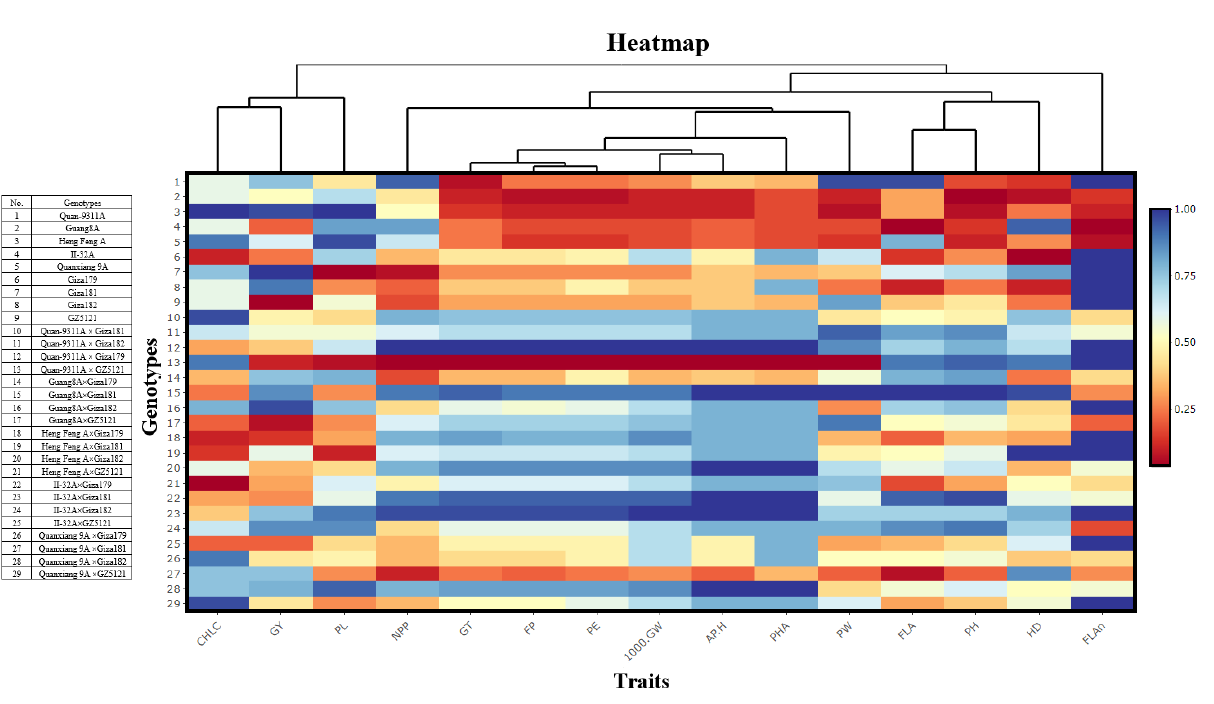
Figure 1. Heatmap analysis of 15 traits across 25 rice genotypes. Heatmap analysis data based on the main values of the traits of each